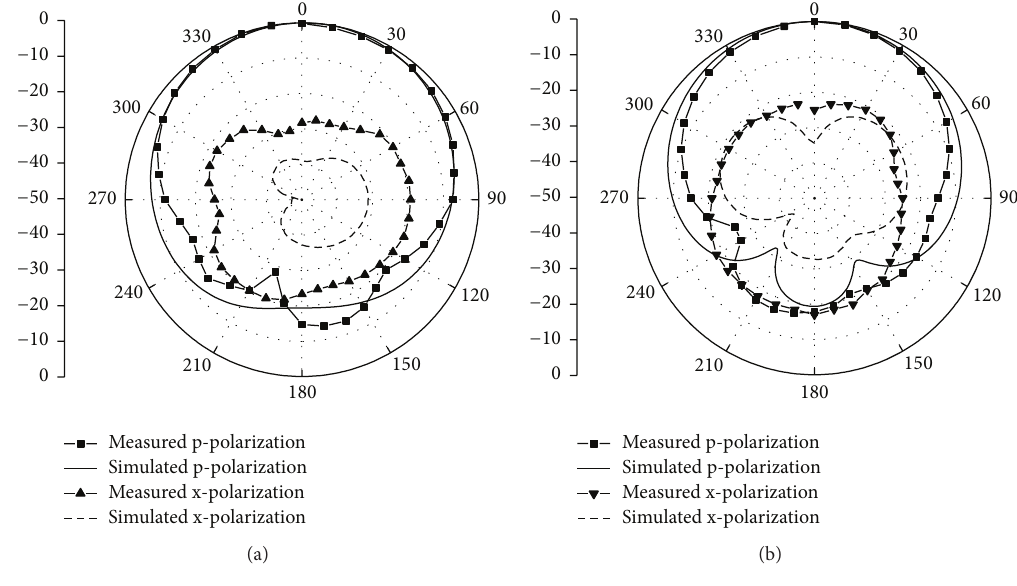
Figure 7: Radiation patterns of port 1: (a) 𝐸 -plane; (b) 𝐻 -plane.